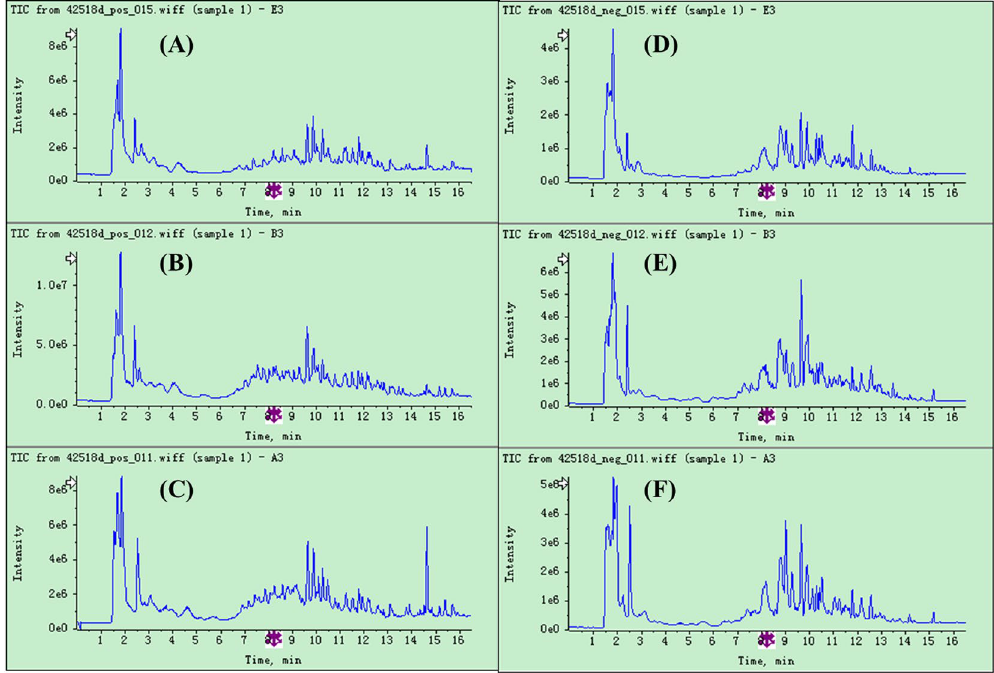
Figure 4. Representative LC-TOF/MS total ion chromatograms (TICs) of rat urine samples from Control ( A ), CDDP + HI ( B ) and CDDP ( C ) groups in positive ion mode, and Control ( D ), CDDP + HI ( E ) and CDDP ( F ) groups in negative ion